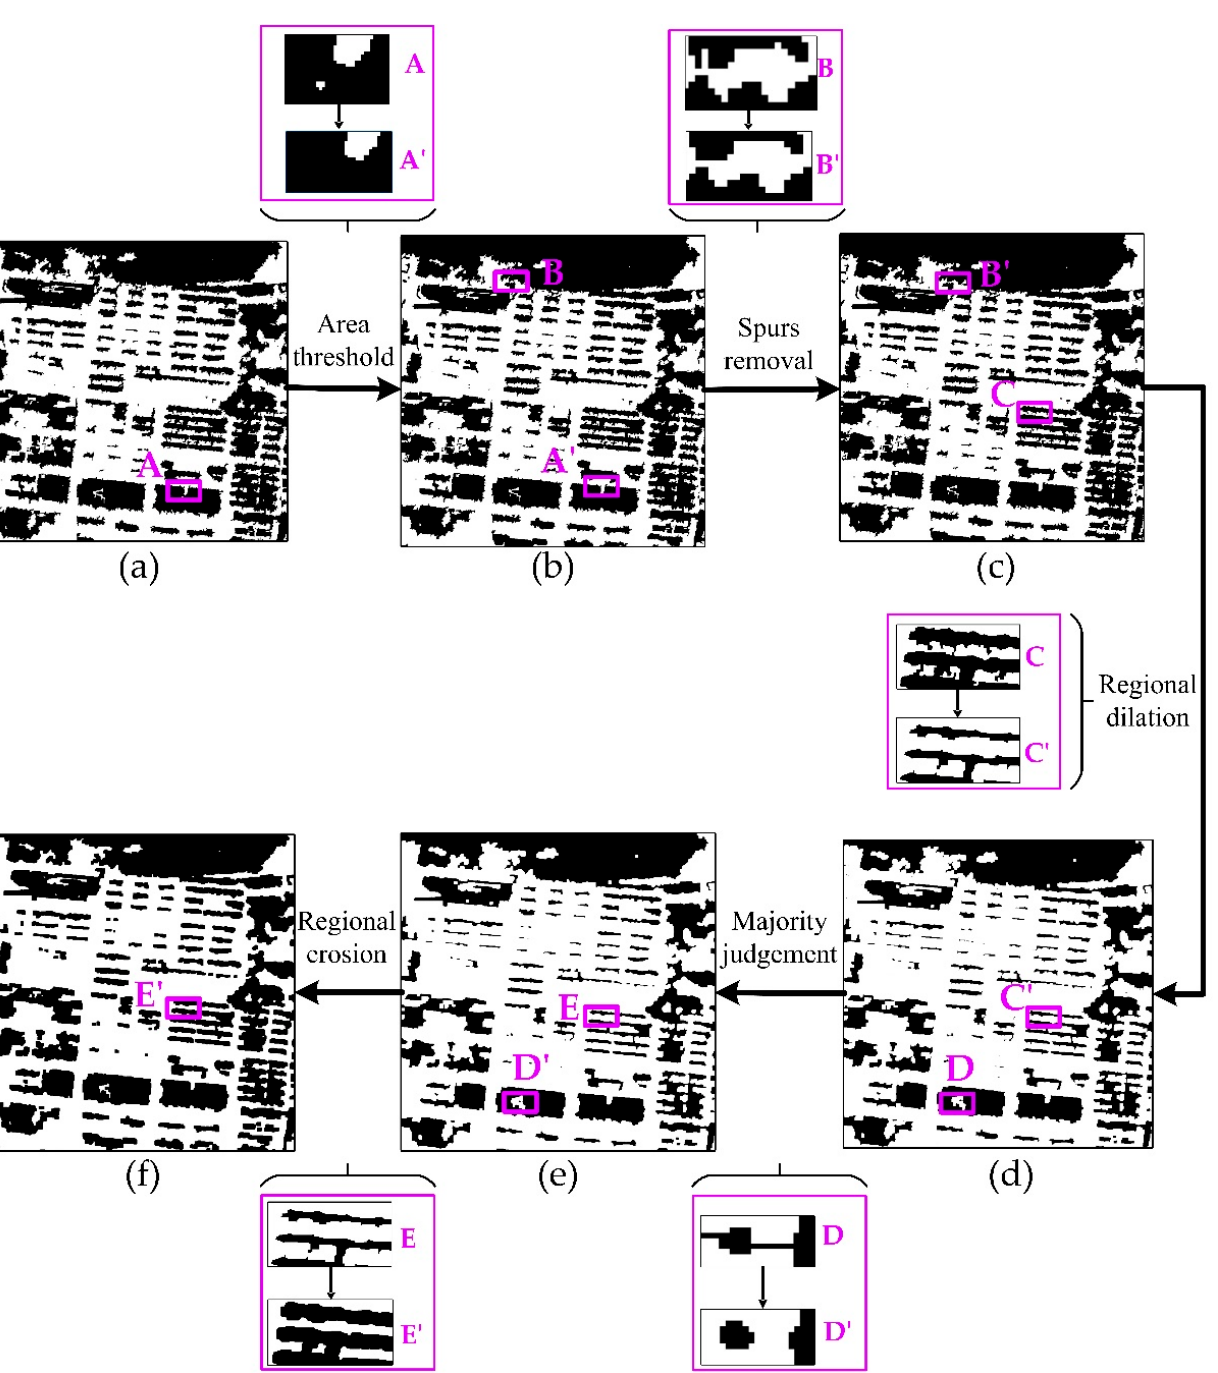
Figure 13. Experiments of data preprocessing: ( a ) binary image of vegetation regions; ( b ) result of area threshold segmentation; ( c ) result of spur removal; ( d ) result of regional dilation; ( e ) result of majority judgment; ( f ) result of regional erosion. The letters A and A’, B and B’, C and C’, D and D’, E and E’, F and F’ represent subareas from the study area, showing the changes during processing in details. The black pixels represent the areas of non-vegetation, or vegetation without obscuring effects in the images while the white pixels represent the areas of the vegetation obscured ISAs.